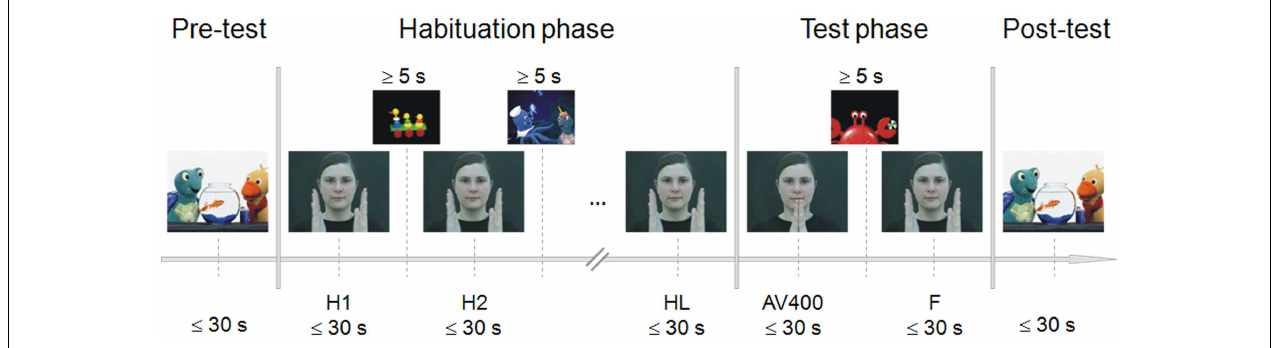
synchronous stimulus (F). Each experimental stimulus was presented as long as the infant looked at it or for a maximum duration of 30s.To attract the child’s attention back to the screen, further sequences of the child movie were presented between habituation trials and between test trials. The child had to look at the screen for at least 5s in order to continue with stimulus